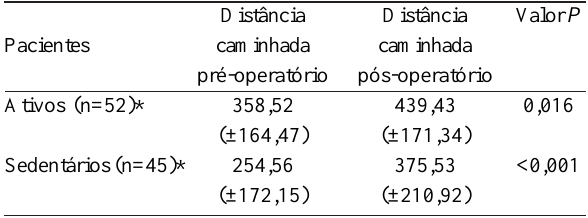
Tabela 2. Distância caminhada em metros no pré e pós-operatórios dos grupos que mantiveram suas características de ativos e